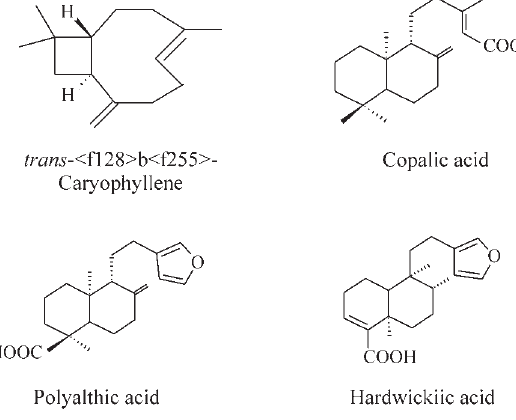
Figure 1 - Terpenes in the oleoresin of Copaifera duckei